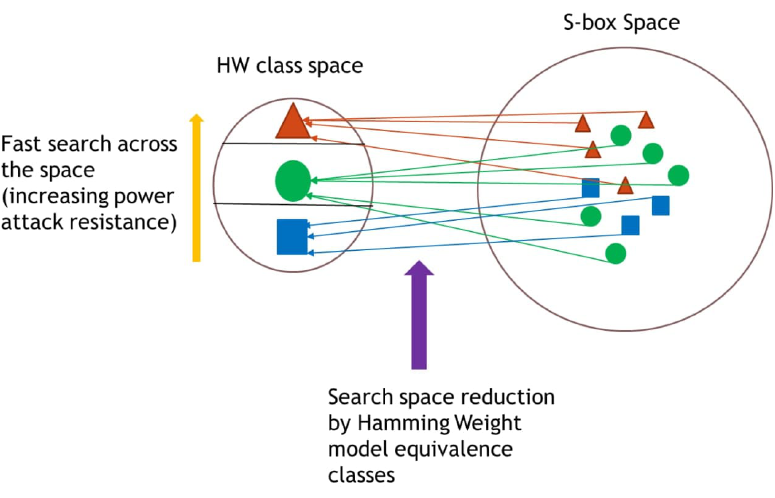
Figure 1. S-box and HW-class search